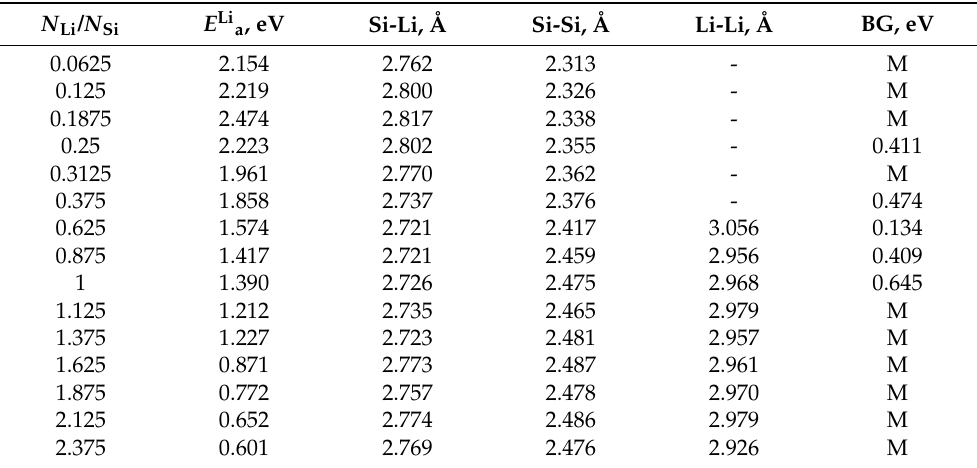
Table 2. Dependence of properties * of the “free-standing silicene sheet” system on the number of adsorbed lithium atoms. N Li / N Si E Li a , eV Si-Li, Å Si-Si, Å Li-Li, Å BG,